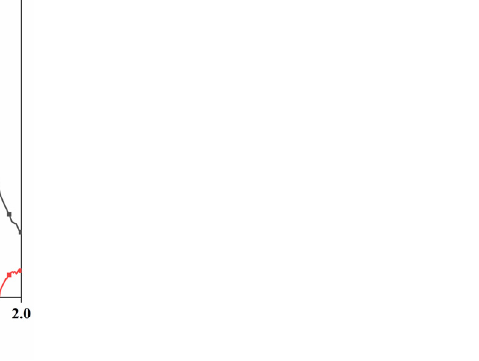
Figure 6. Transverse electric field distribution of fundamental mode and higher-order mode.